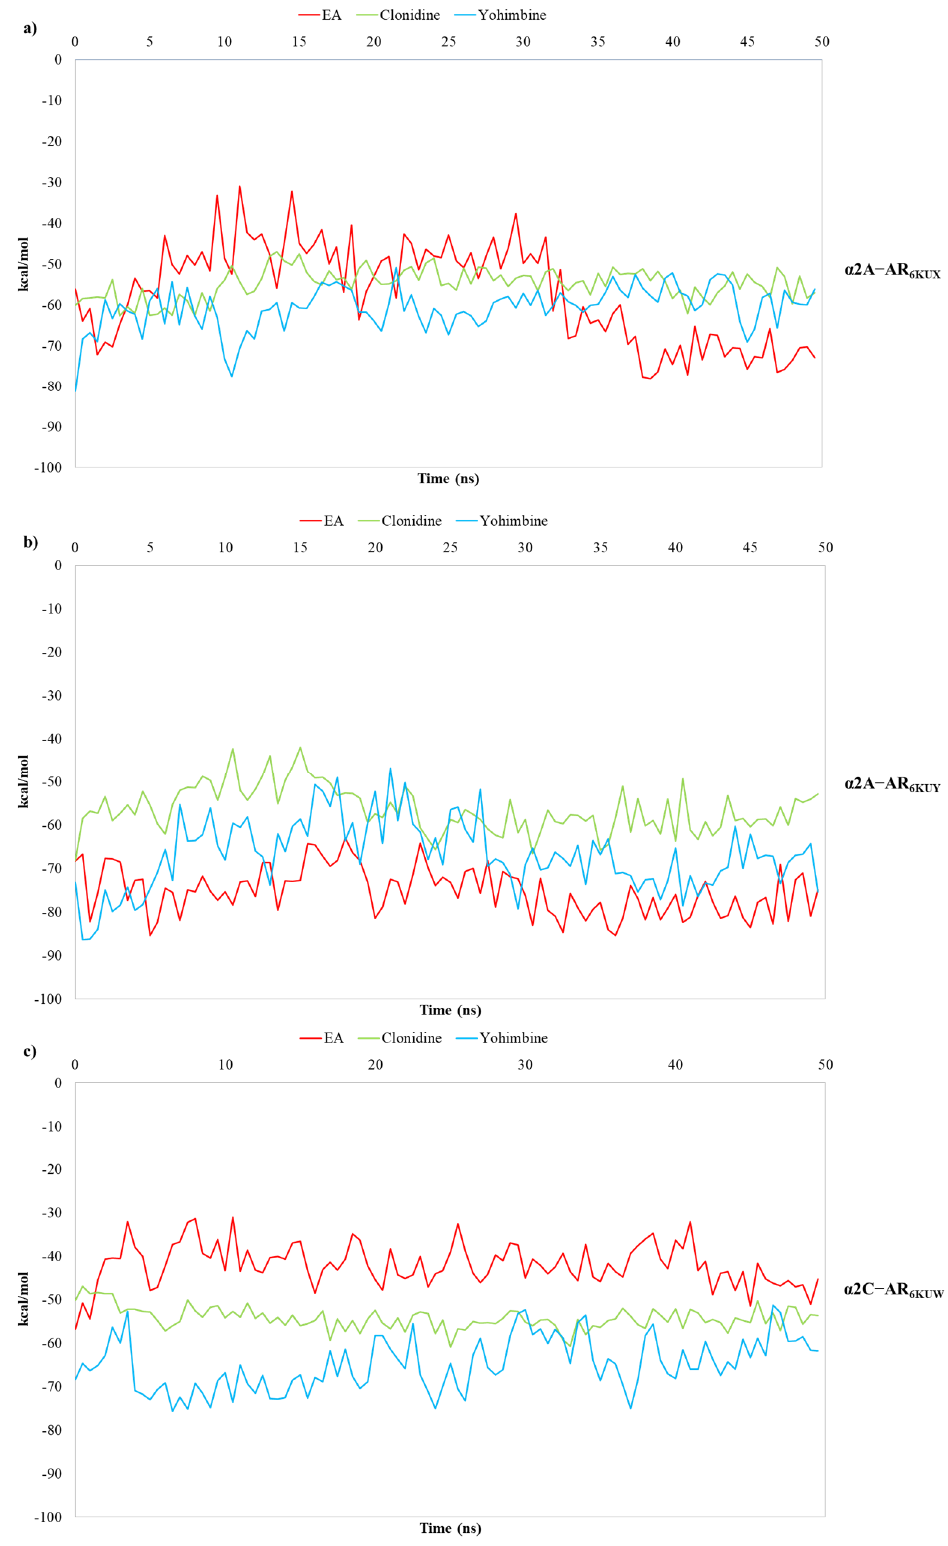
Figure 8. Plots of MM/GBSA trend for EA, clonidine and yohimbine in complex to ( a ) α 2A -AR 6KUX , ( b ) α 2A -AR 6KUY , and ( c ) α 2C -AR 6KUW , during 50 ns of MDs. MM/GBSA analysis reveals that the average calculated binding free energies (ΔGbind) of EA, clonidine and yohimbine complexed with α 2A -AR 6KUX (Figure 7a) are